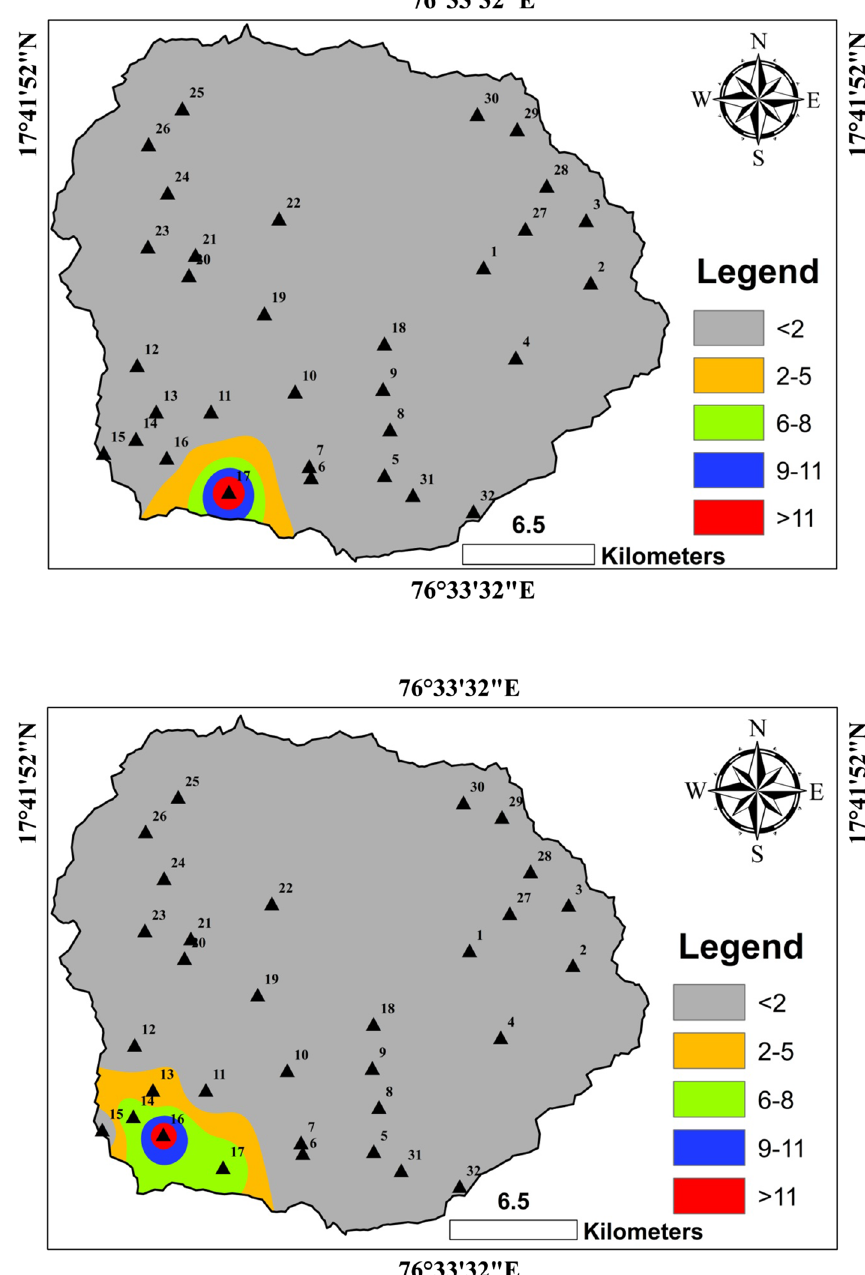
Fig. 18 Geospatial distribution of carbonate (pre-monsoon)